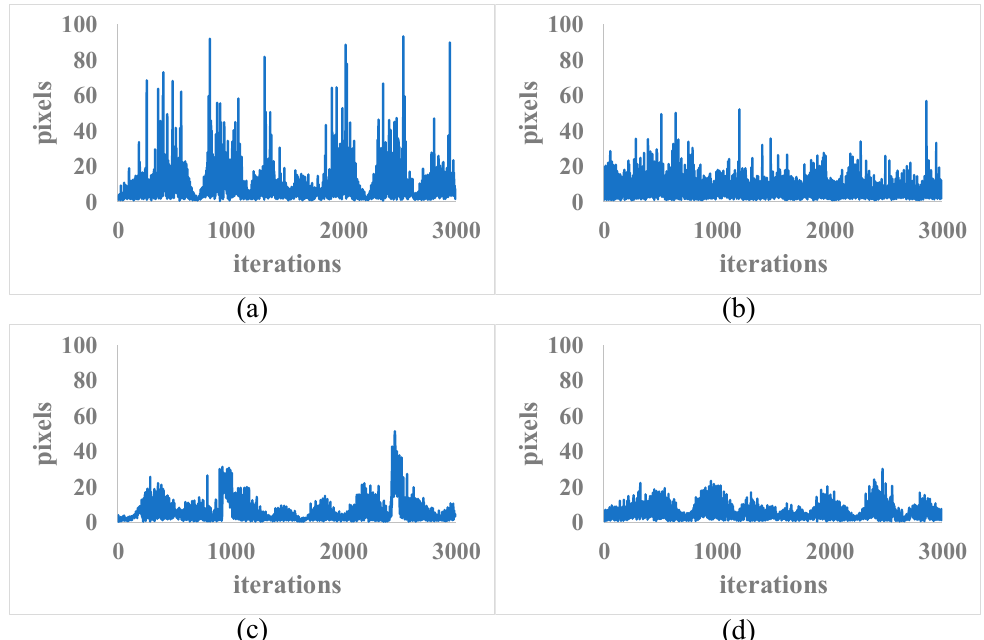
Figure 18. Image error of different strategies in experiment of triple leaf rose path. ( a ) Image error of IBUVS. ( b ) Image error of the original PHUVS. ( c ) Image error of the improved PHUVS with the KF method. ( d ) Image error of the improved PHUVS with the KF-SVSF method.